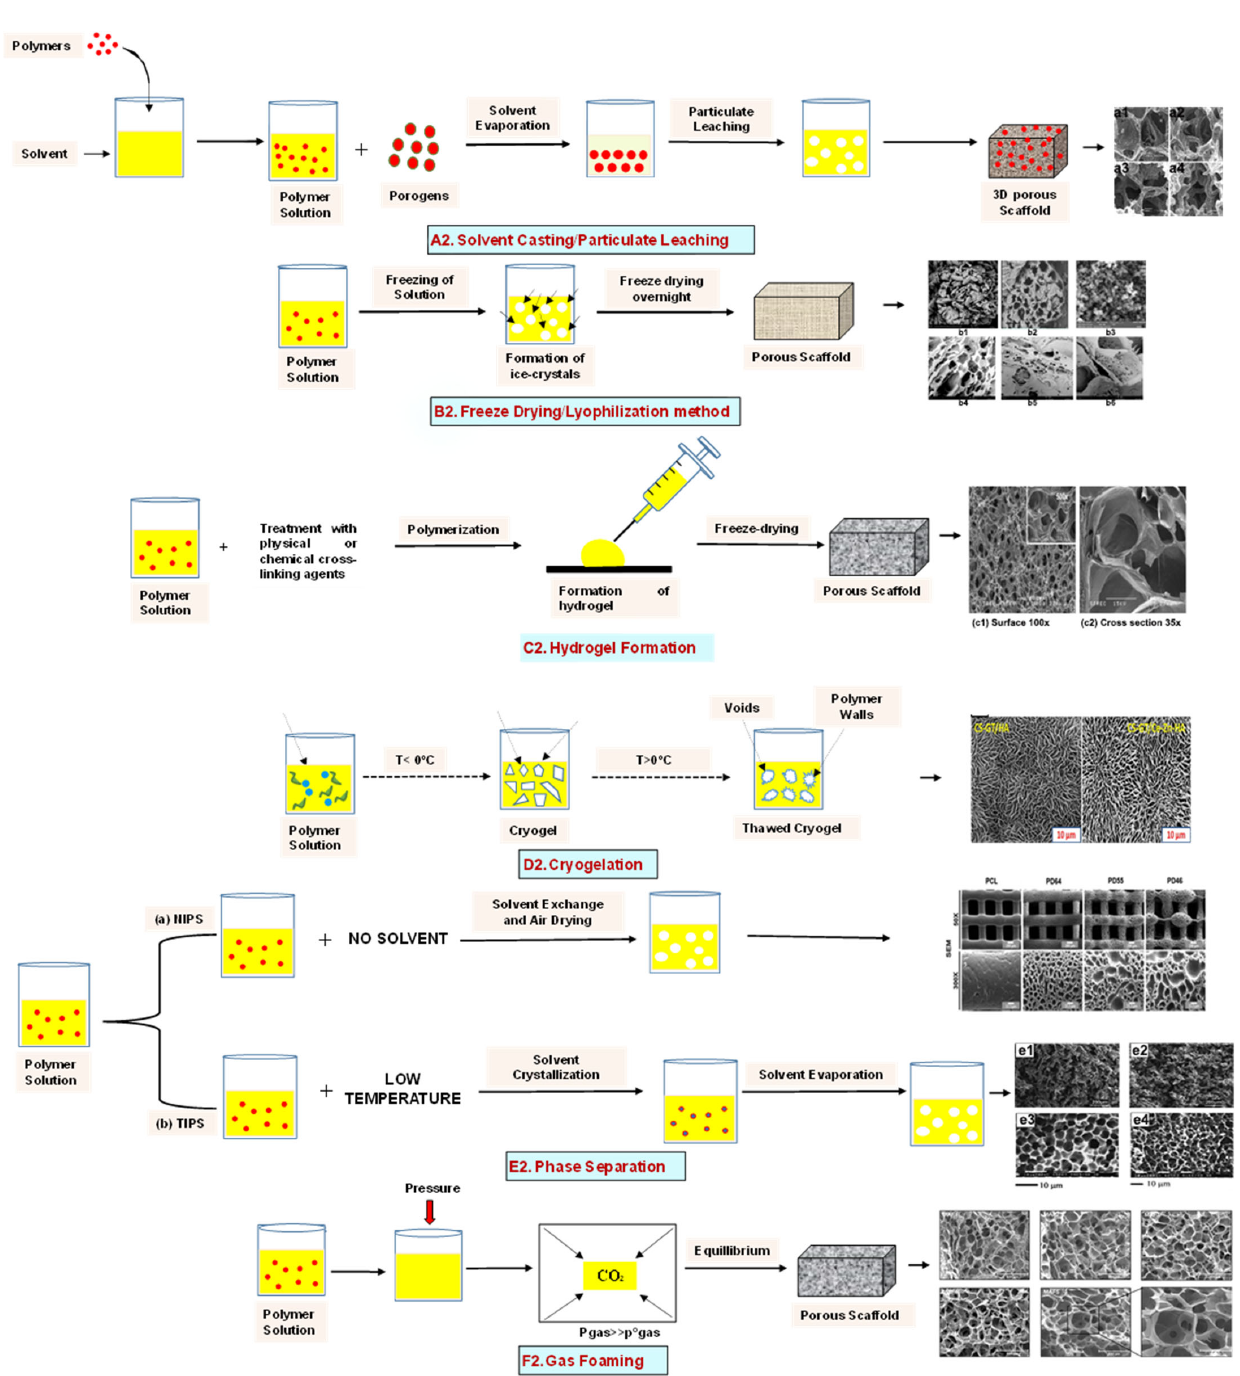
Figure 2. Schematic representation of traditional fabrication methods and microscopic images. ( A2 ) Solvent casting and its microscopic image showing ( a1 ) salt leached, ( a2 ) salt-PEG 200 leached, ( a3 ) salt-PEG 600 leached, and ( a4 ) salt-PEG 1000 leached PCL scaffolds. Reprinted with